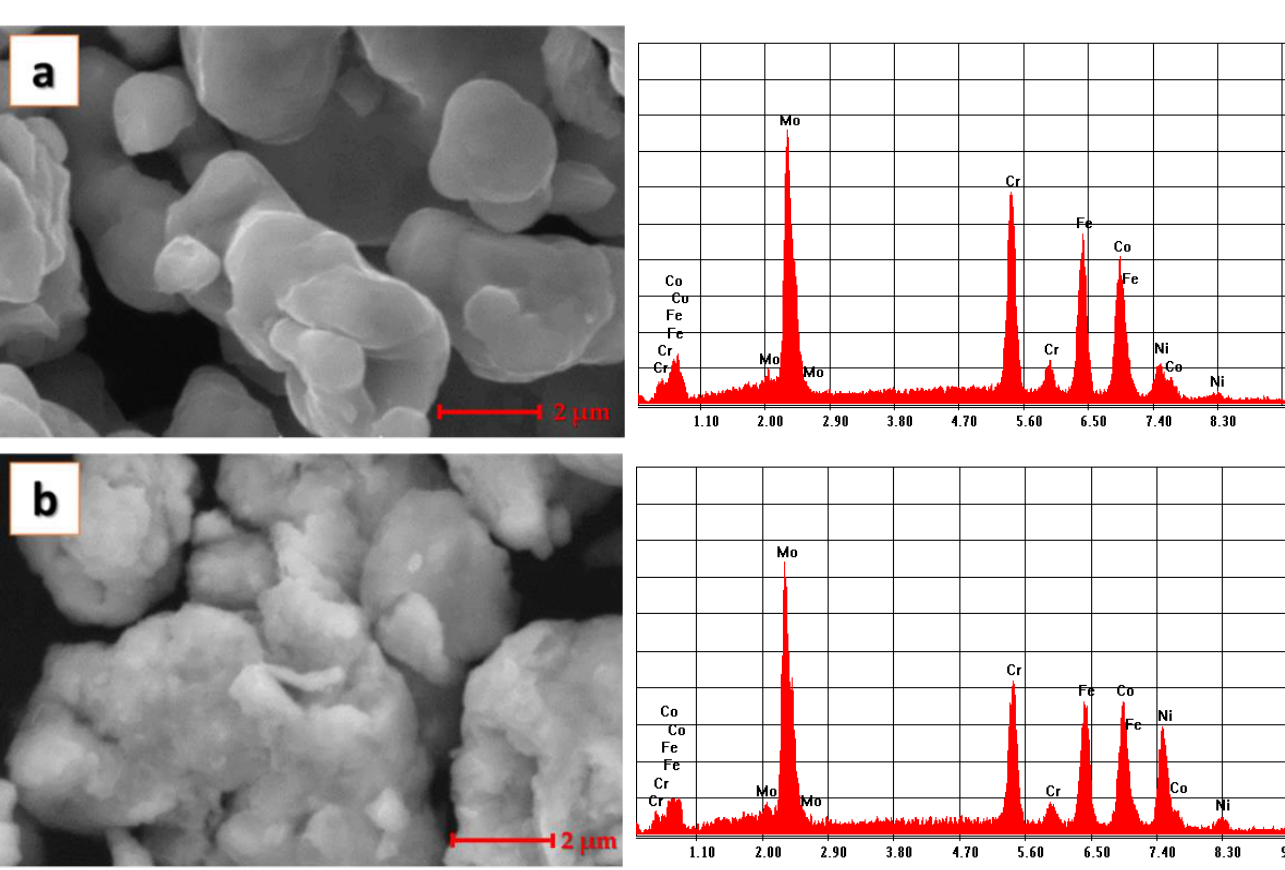
Figure 2. SEM images and results from EDS analyses for the powders used for CoCrFeNiMo 0.85 HEA producing ( a ) homogenized powder, ( b ) mechanically alloyed powder.